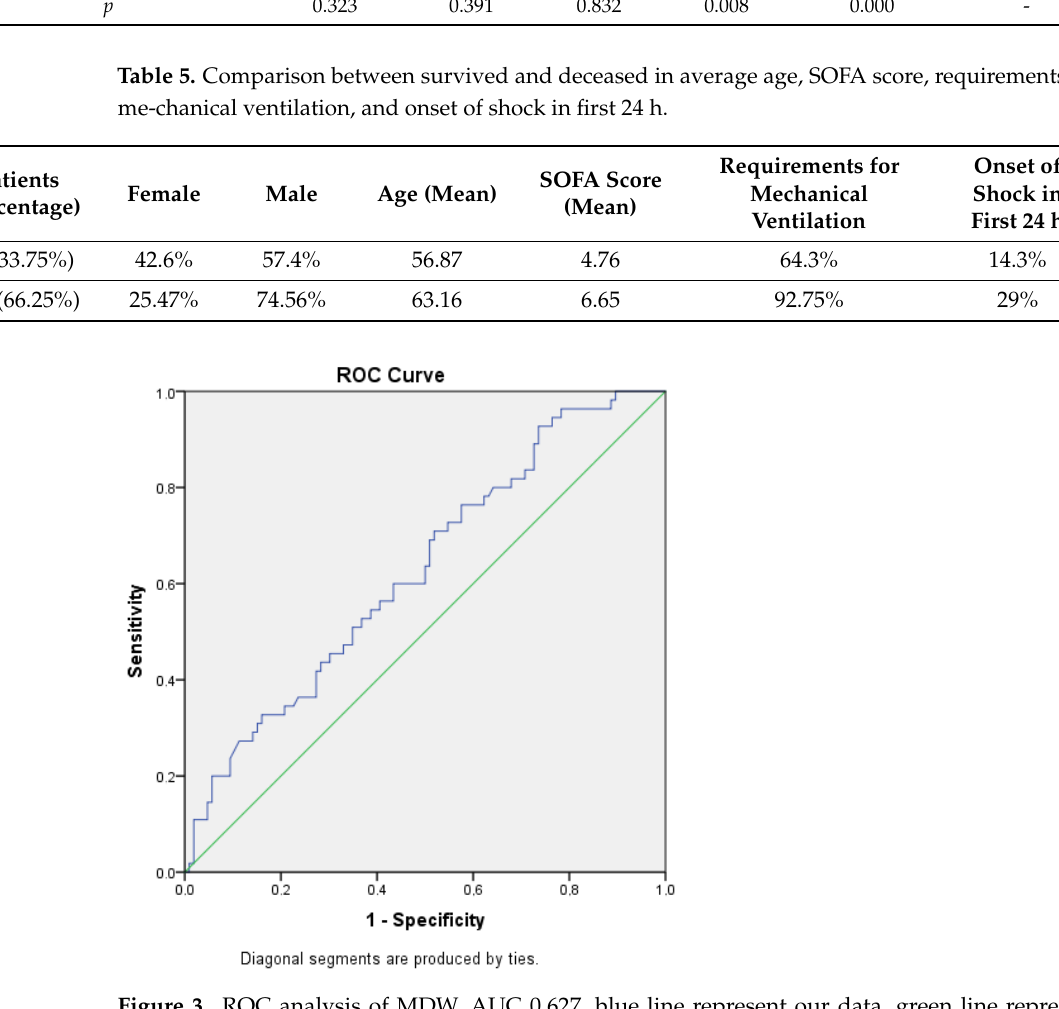
Figure 3. ROC analysis of MDW, AUC 0.627, blue line represent our data, green line represent uniformative test.